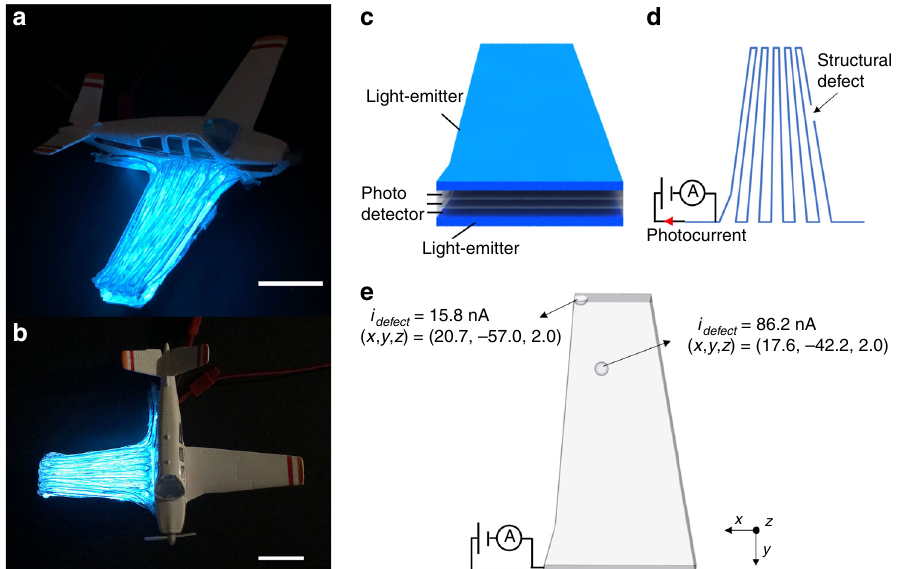
Fig. 5 Application of a printed bi-functional light-detecting and light-emitting 3D-structure in detecting structural defects. a Photograph of a printed aeroplane wing that has light-emitters at the top and bottom layers, and, light-detectors in the bulk of the wing. Scale bar, 2 cm. b Top-view photograph of the printed aeroplane wing. Scale bar, 2 cm. c Schematic of the print layers of the aeroplane wing. Top and bottom layers are light-emitters, and the middle 3 layers are light-detectors. d Schematic of the print path for 1 layer. A photocurrent is measured from an external multimeter connected to the opposing electrodes within the printed photodetecting fi lament. The presence of a structural defect reduces the magnitude of the photocurrent. e Spatial detection of structural defects at 2 points within the wing by measuring the magnitude of the photocurrent after defects are made. The spatial coordinate of the defect is obtained by correlating the photocurrent magnitude with the severed length of the photodetecting fi